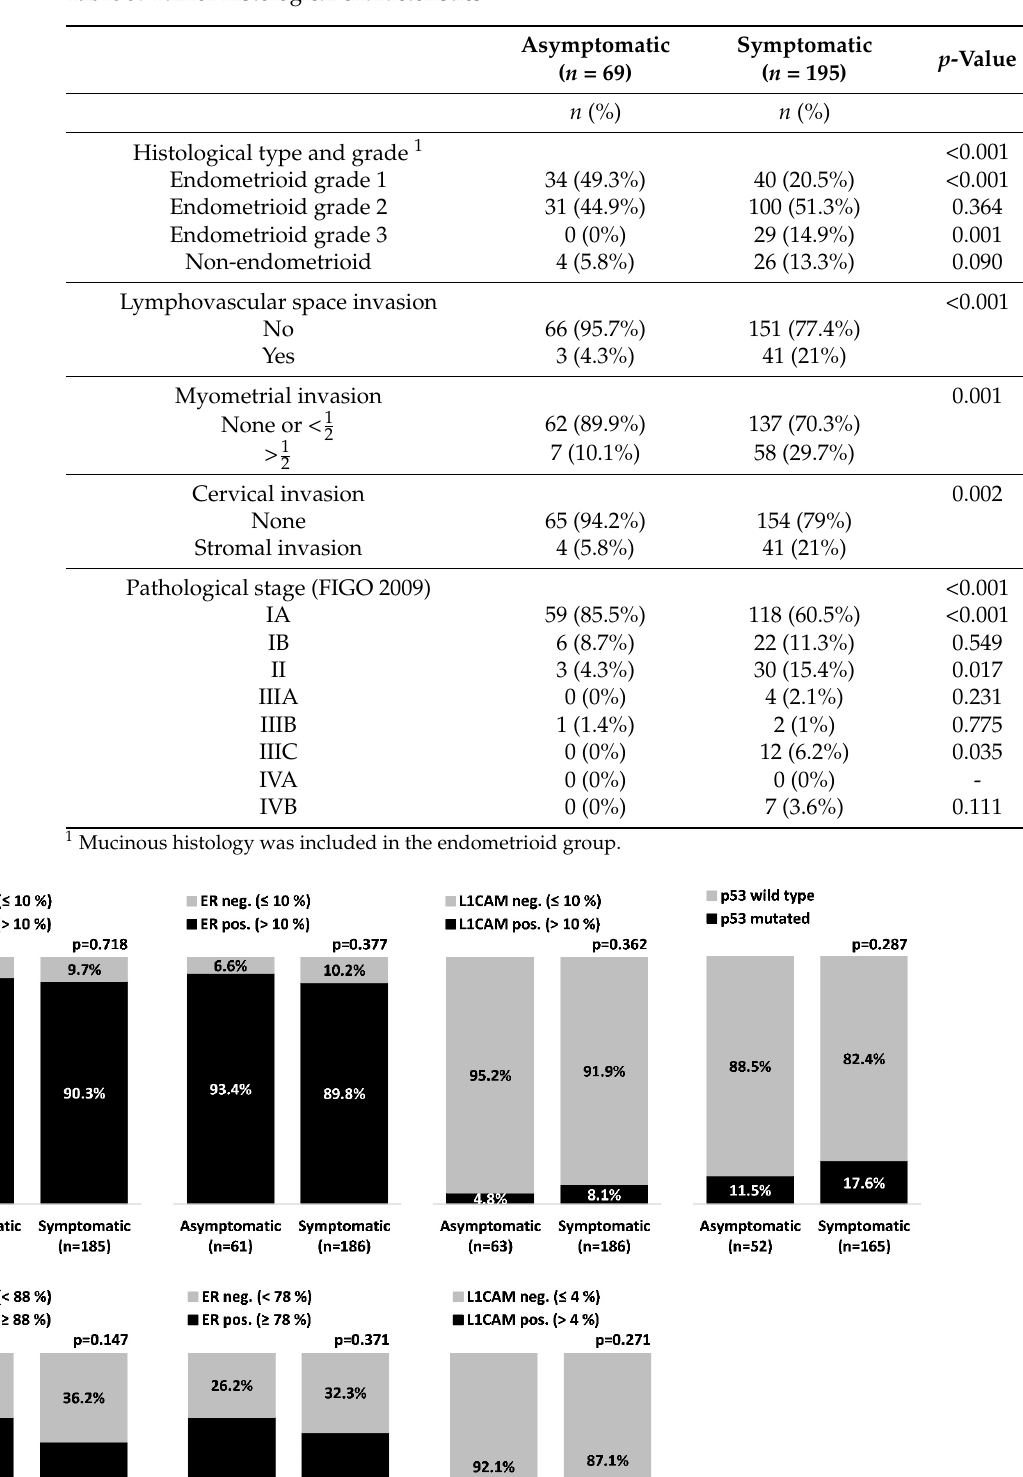
Table 3. Tumor histological characteristics.